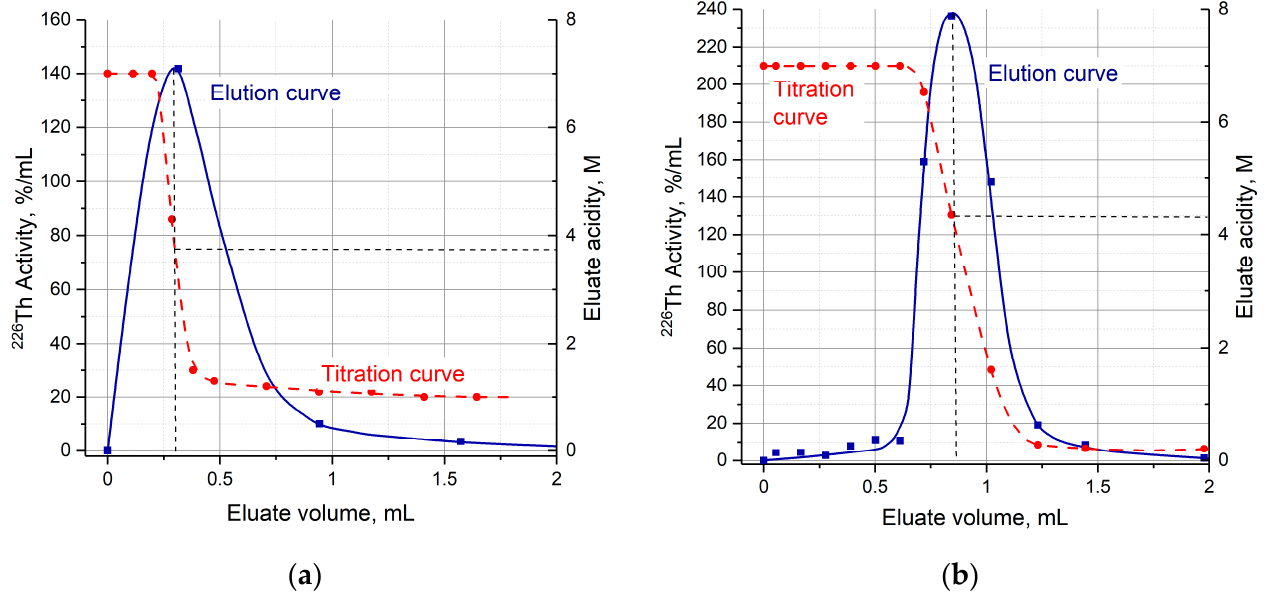
Figure 6. Typical 226 Th elution and titration curves. ( a ) Elution of 226 Th from TRU resin with 1 M HCl; ( b ) elution of 226 Th from UTEVA resin with 0.2 M HCl.